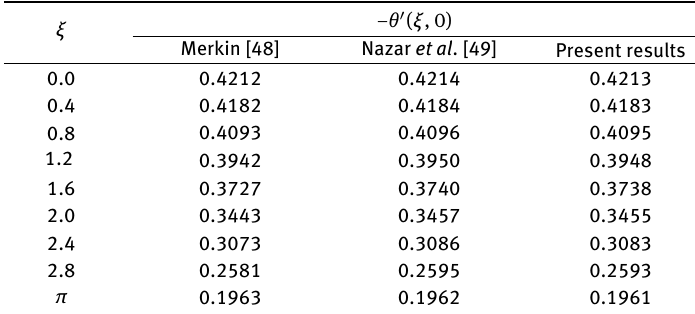
Table 1: Values of the local heat transfer coefficient ( − θ (cid:48) ( ξ , 0) ) for various values of ξ with ϕ = 0.0, ε 1 = 0.0, ε 2 = 0.0, γ = 0.0, Pr =